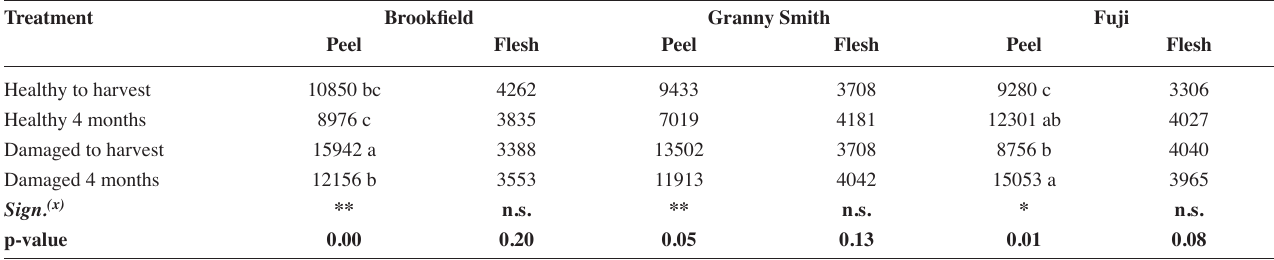
Tab. 7: Quantification of ORAC (μmol of Trolox equivalent/100g) in peel and flesh of healthy and sunburned apple, of organic orchard, from harvest to 4 months of cold storage, Season 2012/2013. Treatment